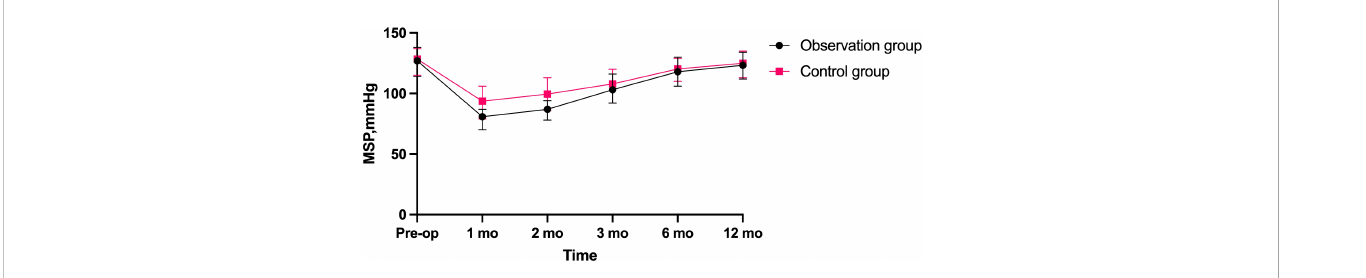
FIGURE 4 Comparison of maximum squeeze pressure (MSP) changes in anal canal between two